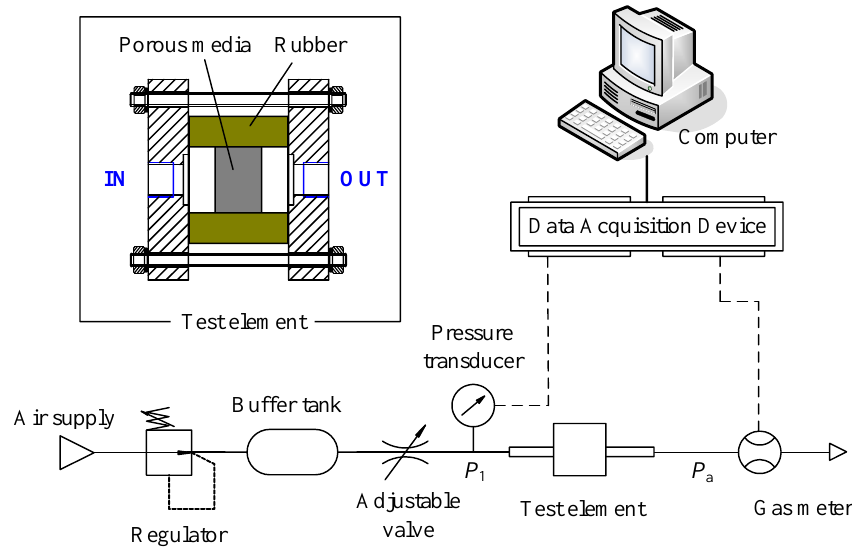
Figure 4. Schematic of the apparatus for steady-state method.